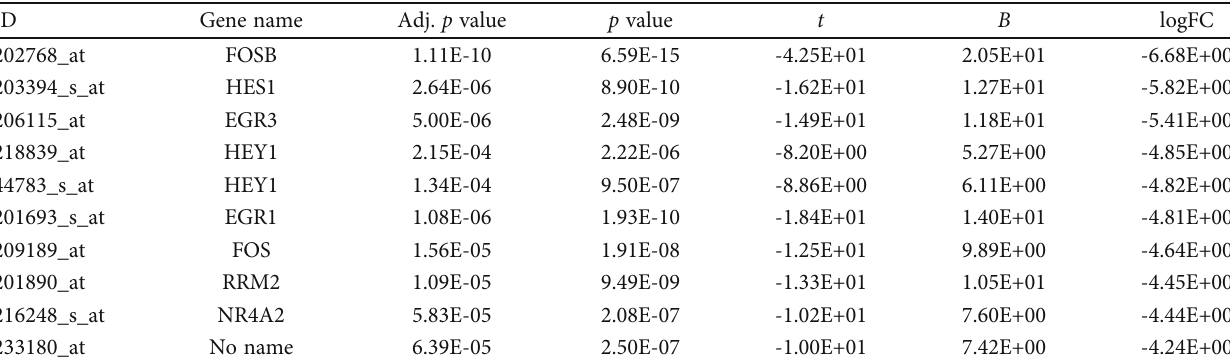
Table 2: Top ten downregulated DEGs in GSE61302 between undi ff erentiated human primary ADSCs and mature adipocytes. ID